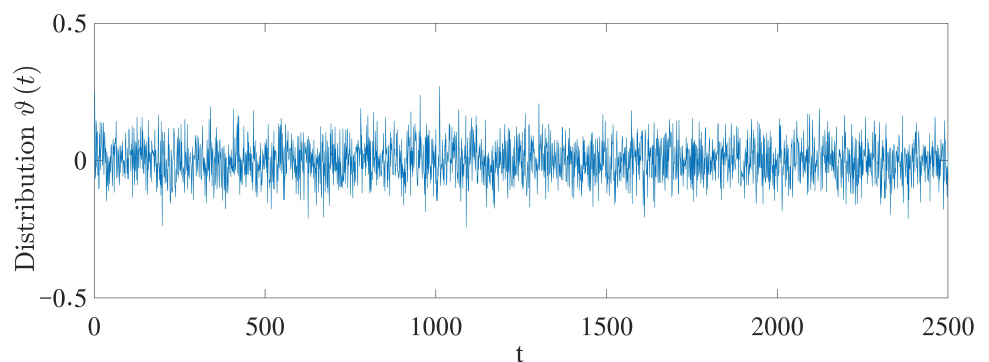
Figure 5. The Brownian motion κ ( t ) .